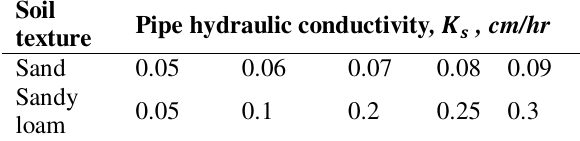
Values of hydraulic conductivity of the buried ceramic pipe.